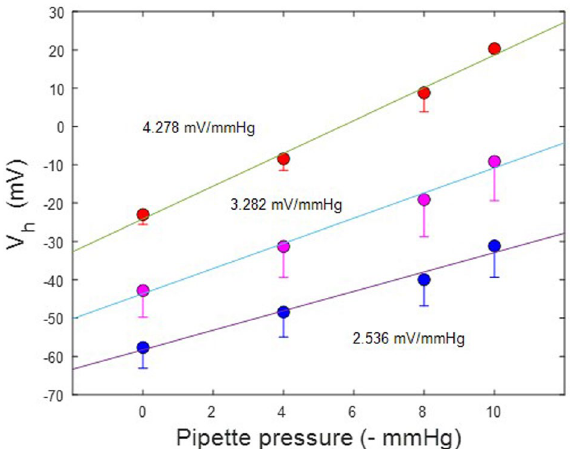
Figure 8. Shift in V h due to tension versus initial V h . This plot shows that sensitivity to tension differs depending on initial V h . Upon categorization of initial V h with values greater than and less than − 30 mV, differences in sensitivity to tension are exposed. In those patches with initial V h greater than − 30 mV (red symbols; − 23.0 ± 2.6 mV; 4.28 mV/mmHg; n = 3), sensitivity is nearly double that of the group with initial V h less than − 30 (blue symbols; − 57.6 ± 5.4 mV; 2.536 mV/mmHg; n = 4). For comparison, the relationship for all average patches is shown (magenta symbols), where a sensitivity to tensions is 3.3 mV/mmHg. This latter relationship is derived from data in Fig. 7. Linear fits provide the slope sensitivity.